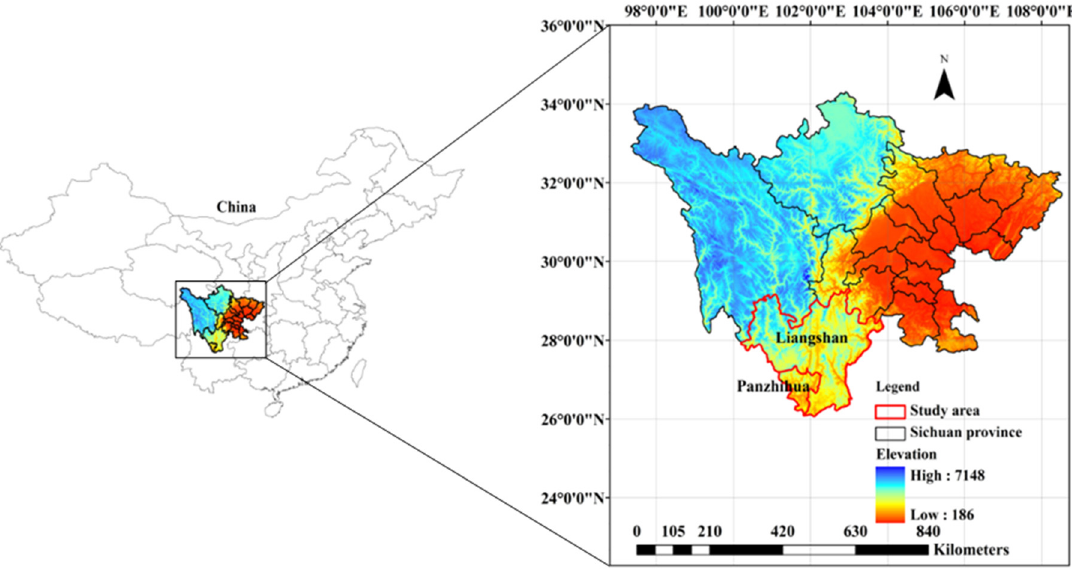
Figure 1. Study area in Sichuan Province, China.